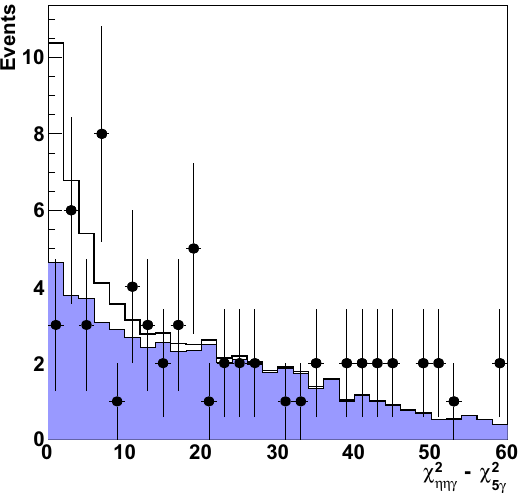
Fig. 4 The χ 2 ηηγ − χ 2 (left panel) and M ηη distributions for data √ 5 γ s = 1 . 57–2.00 GeV selected with events from the energy region the additional condition χ 2 φη − χ 2 ηηγ > 20 (points with error bars). For the M ηη distribution, events are selected with the tighter condition